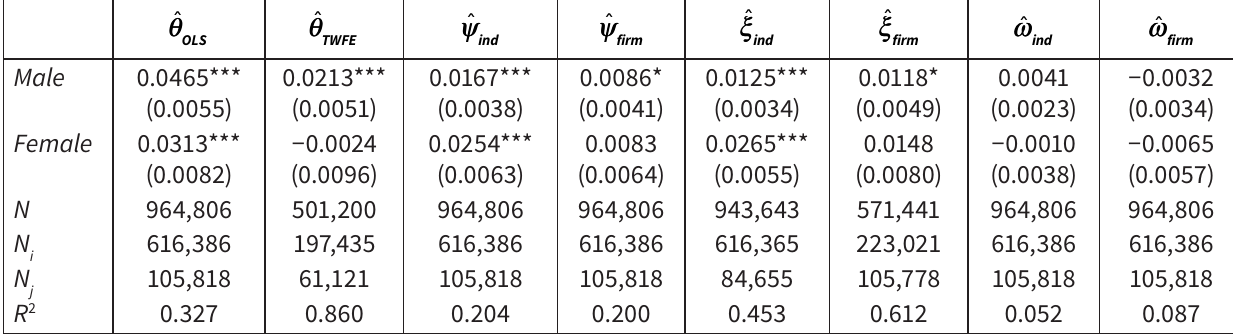
Decomposition of co-worker gains by gender